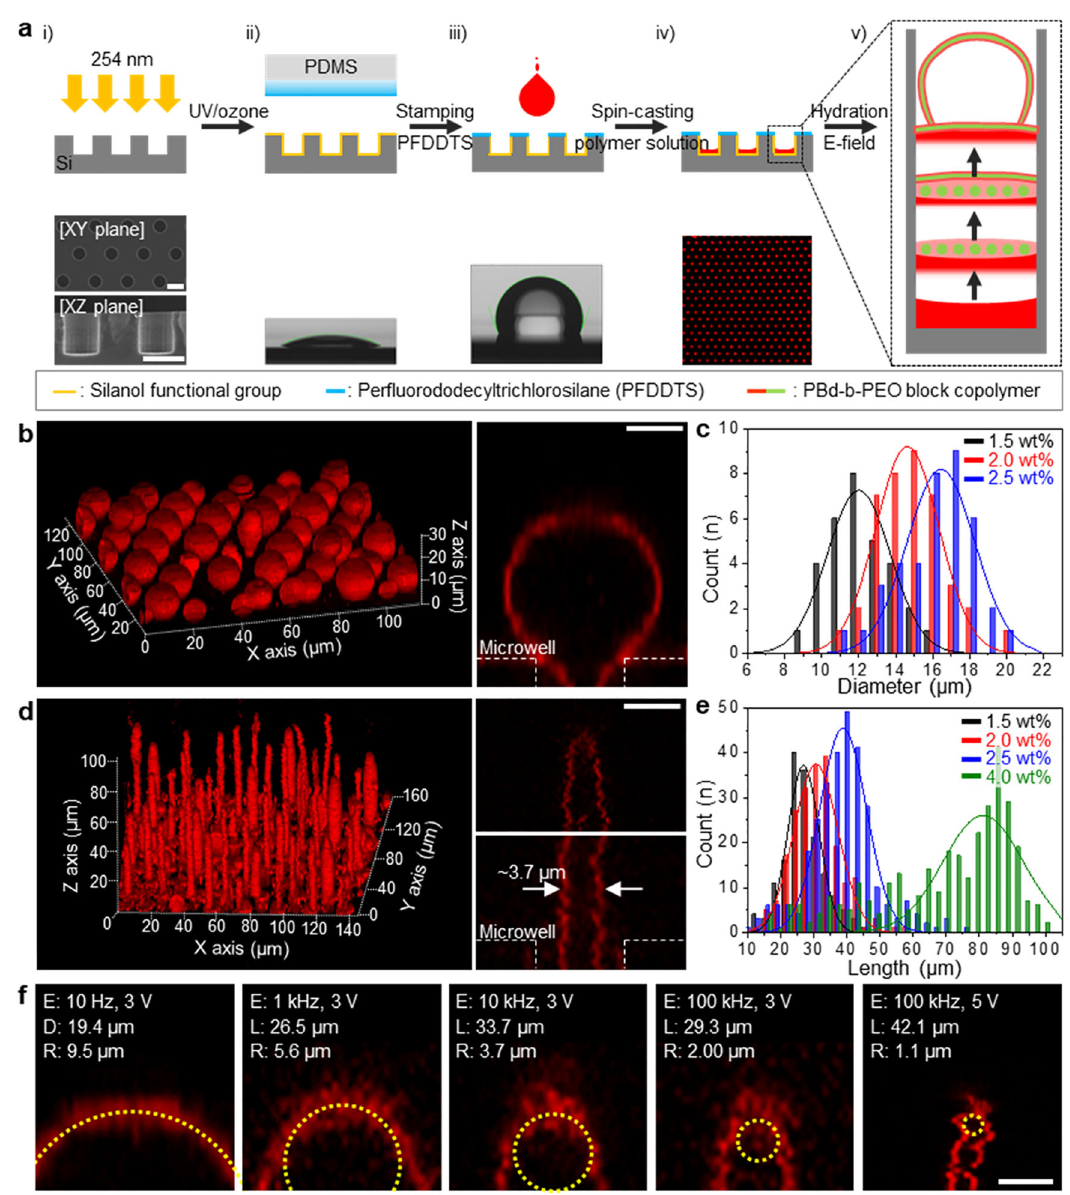
Fig. 2 Formation of uniform 3DBCPM arrays on a topographically and chemically structured Si microwell template. a Schematic illustration of fabrication steps for 3DBCPMs and corresponding images: (i) surface termination with hydroxyl groups via ultraviolet (UV)/ozone treatment and scanning electron microscopy (SEM) images of Si microwell template; (ii) formation of fl uorocarbon-based self-assembled monolayer (SAM) via micro-contact printing and contact angle measurement of the UV/ozone treated template; (iii) isolation of hydrophilic microwells by the hydrophobic SAM region and CA measurement of the SAM-treated template; (iv) patterning of amphiphilic block copolymer domains via spontaneous dewetting and a fl uorescence microscopy image of the block copolymer-coated template; and (v) sequential processes for the formation of 3DBCPM through electric fi eld-assisted self- assembly during hydration. Scale bar: 10 μ m. b Confocal fl uorescence microscopy image of spherical 3DBCPM array (left) and its magni fi ed cross-sectional view (right). Scale bar: 5 μ m. c Size distributions of spherical 3DBCPMs produced with different block copolymer concentrations. d Confocal fl uorescence microscopy image of cilia-like 3DBCPM array (left) and its magni fi ed cross-sectional view (right). Scale bar: 5 μ m. e Length distributions of cilia-like 3DBCPMs produced with different block copolymer concentrations. f 3DBCPM with diverse shapes and different curvatures produced from 2.5 wt% of PBd-PEO under different conditions, where E, D, L, and R represent the electric fi eld and the diameter, length, and radius of 3DBCPM, respectively. Scale bar: 5 μ